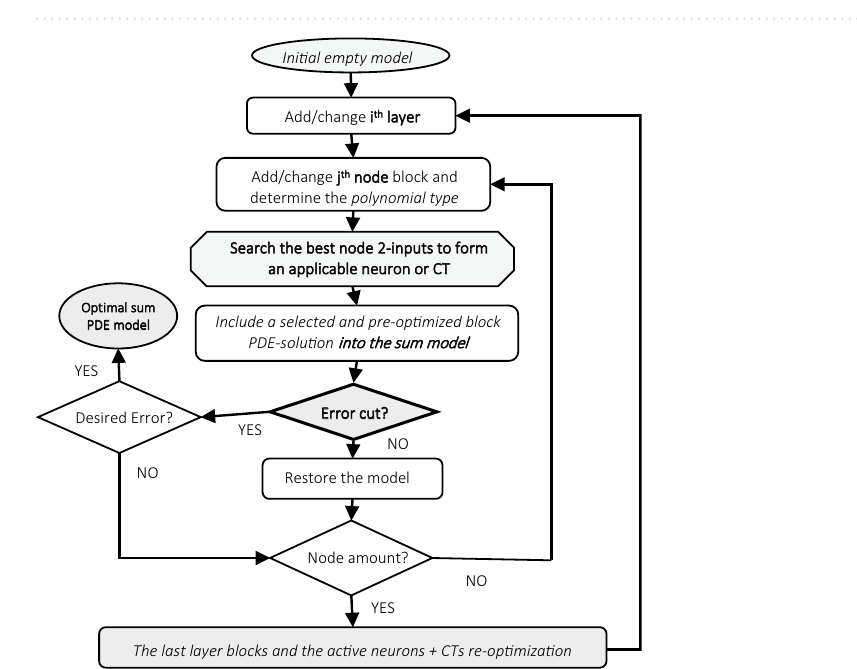
Figure 5. Development of D-PNN gradual models using new added sum PDE components formed in nodes of the parallel expanded PNN